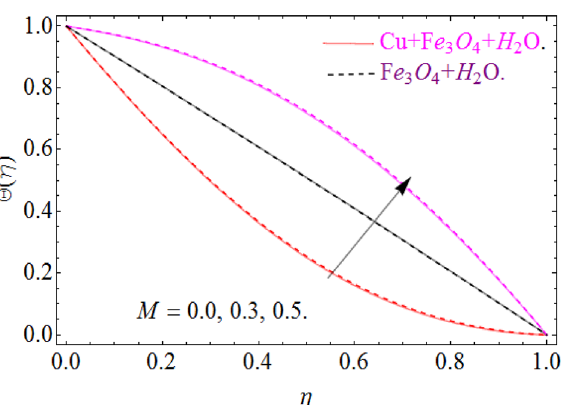
Figure 17a,b are plotted, in order to scrutinize the temperature profile and heat transfer from the cone and the disk surface within the conical gap, according to case 2 (a stationary cone with the rotating disk). It can be seen that case 2 gains high heat transfer rate only for fixed wall temperature (n = 0). However, cooling process increases for a stationary cone and rotating disk for a high range of radially varying disk temperature distribu- tion. Figure 18 summarized case 3 (co-rotating disk and cone) situation. It is concluded that with the co-rotation of the disk and cone, the temperature of the system rapidly reduces. Finally, the case 4 (both disk and cone are